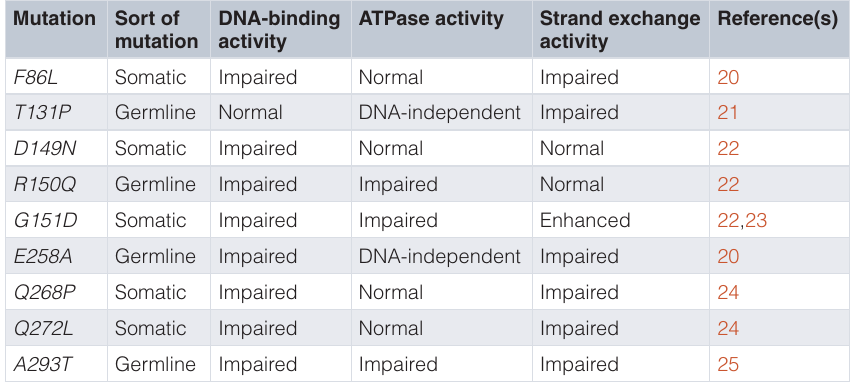
Table 1. Recently identified RAD51